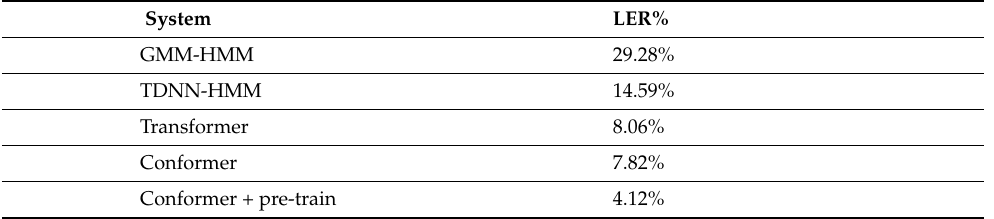
Table 11. LER(%) results obtained with various ASR baseline